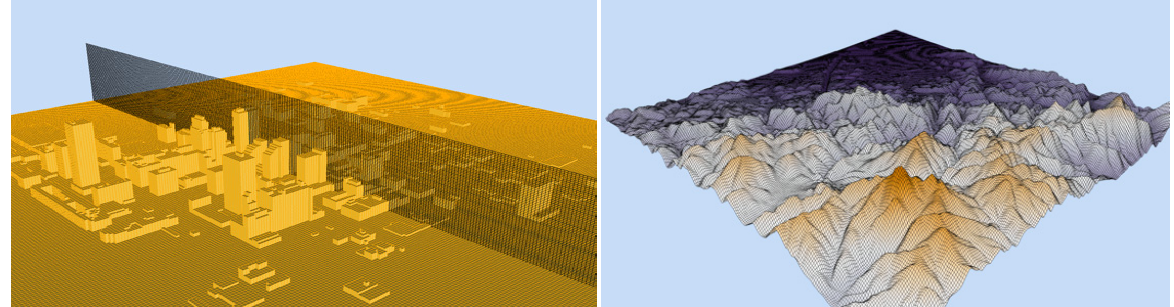
Figure 1. Grids produced by Aeolus modeling system for ( left ) the central business district in Oklahoma City showing the vertical resolution and ( right ) a region with complex terrain.